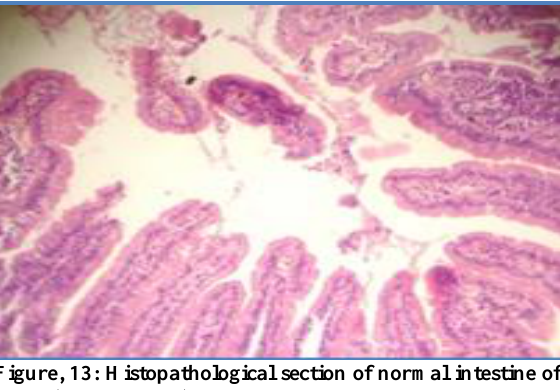
Figure, 13: Histopathological section of normal intestine of mice. (H and E 40X).